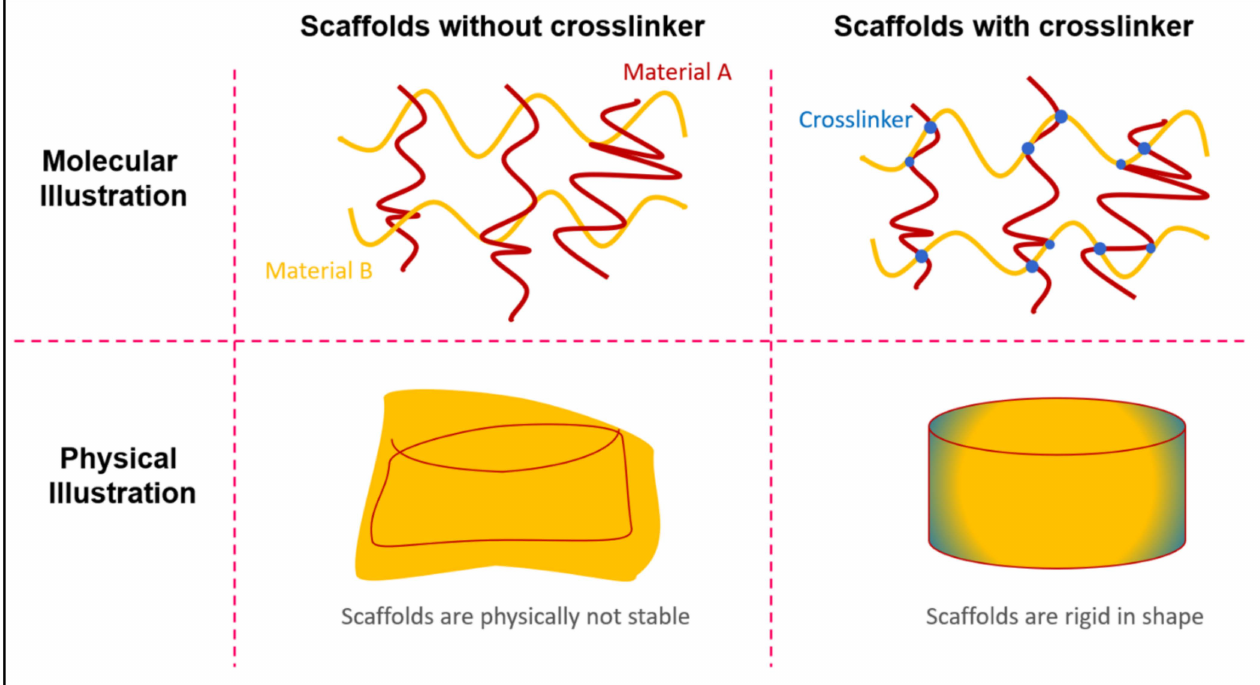
Figure 5. Illustration of the enhancement of a scaffold’s mechanical properties by employing the crosslinking processes. The intermolecular crosslinking of collagen-based scaffolds, either through chemical or physical methods, can modify their mechanical properties [12,56]. However, some well- known crosslinking agents, such as glutaraldehyde (GTA), glyoxal, and glycol diglycidyl ether, are toxic [64,65]. According to Hua et al. (2020), sodium tripolyphosphate